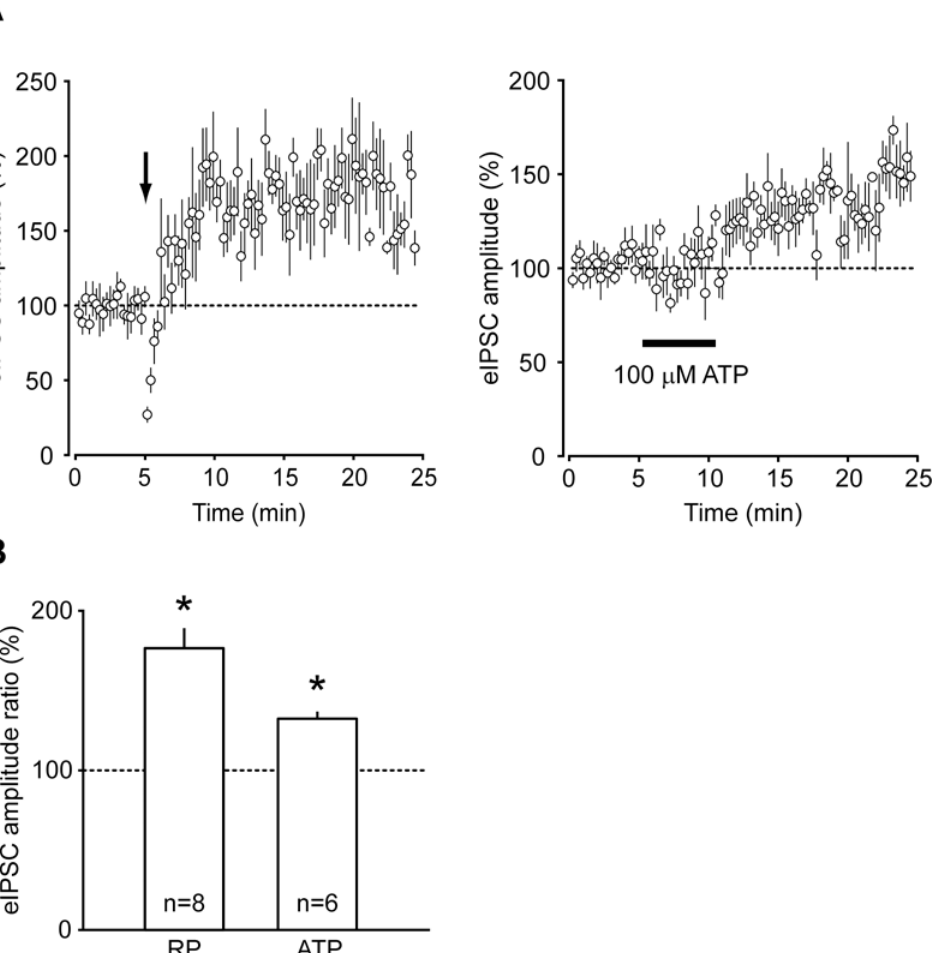
Fig 2. Rebound potentiation (RP) and purinoceptor-mediated long-term potentiation (PM-LTP) of eIPSCs at basket cell-PC synapses. (A) Time course changes of eIPSC amplitude in the course of RP (n = 8, left panel) and PM-LTP (n = 6, right panel). RP was induced by depolarization pulses given to individual PCs at the time point indicated by an arrow. PM-LTP was induced by bath-application of 100 μ M ATP during the period of 5 min indicated by a horizontal bar. (B) Mean amplitude of eIPSCs during the period of 10 to 15 min after induction of RP or PM-LTP. Asterisk indicates a statistically significant difference compared to mean amplitude of eIPSCs before induction of RP or PM-LTP (p <